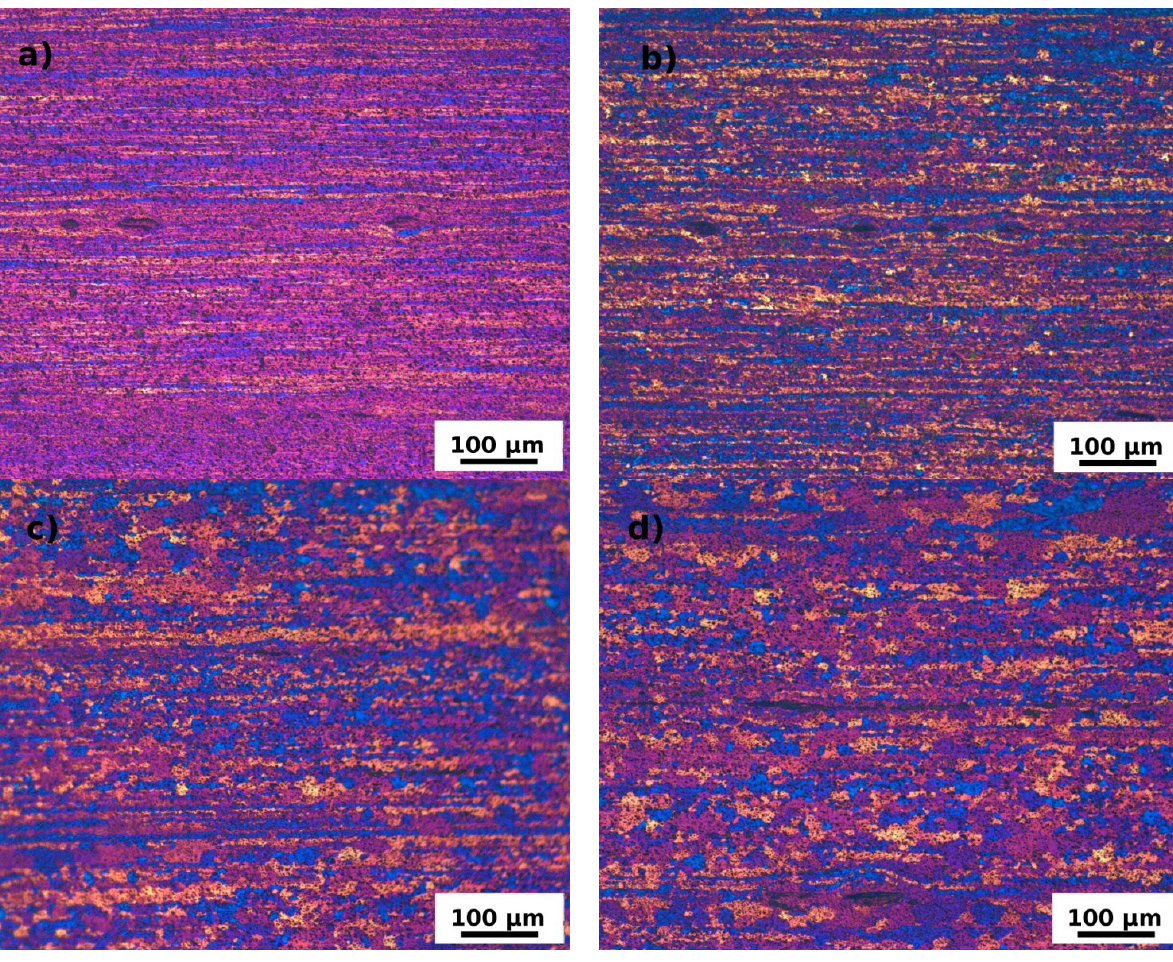
Figure 5. LOM micrographs of the F3 material in the initial state ( a ) after ARB processing; and annealing up to ( b ) 280 °C; ( c ) 380 °C; and ( d ) 440